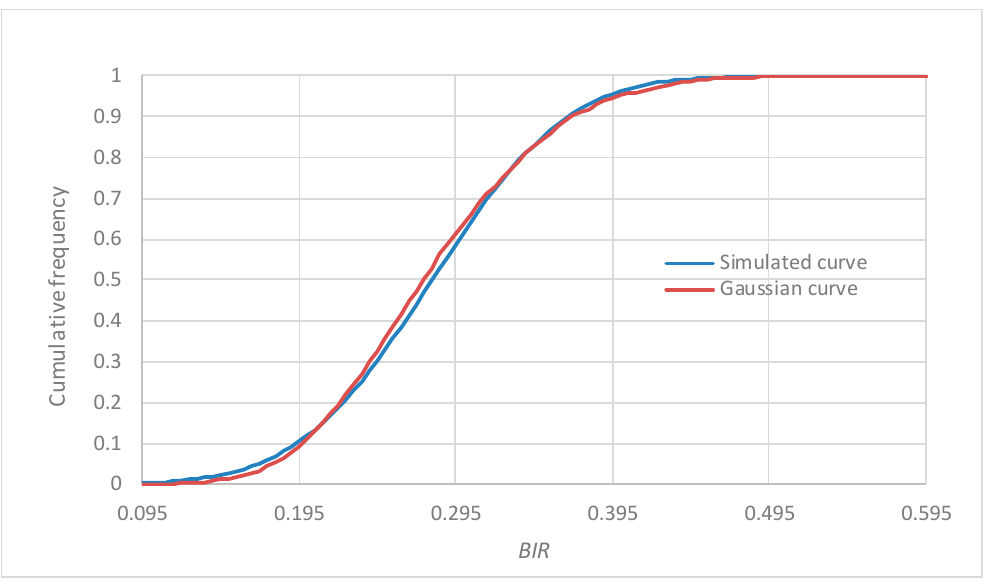
Figure 2. Comparison between simulated and analytical cumulative frequency curves. Table 7. Classes of Table 7. Classes of risk.